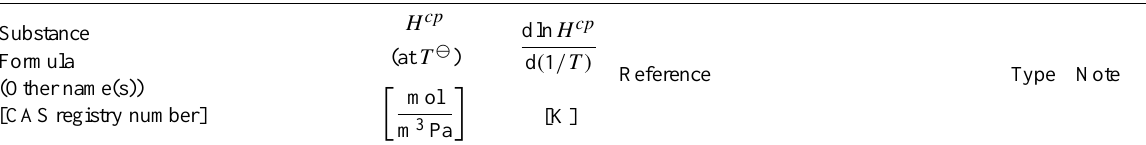
Table 6: Henry’s law constants for water as solvent